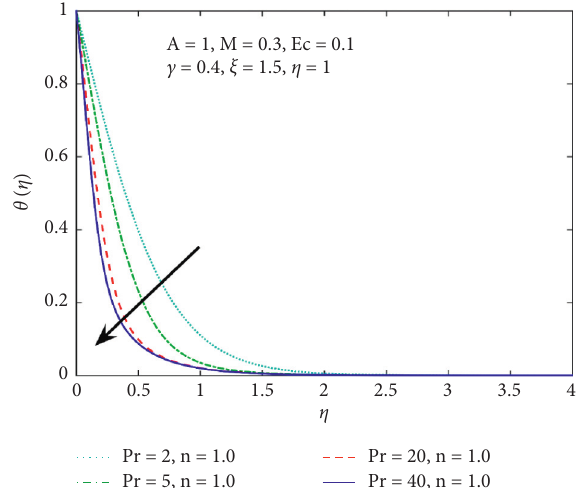
Figure 7: Thermal profile θ ( η ) for different values of Prandtl numbers ( Pr )